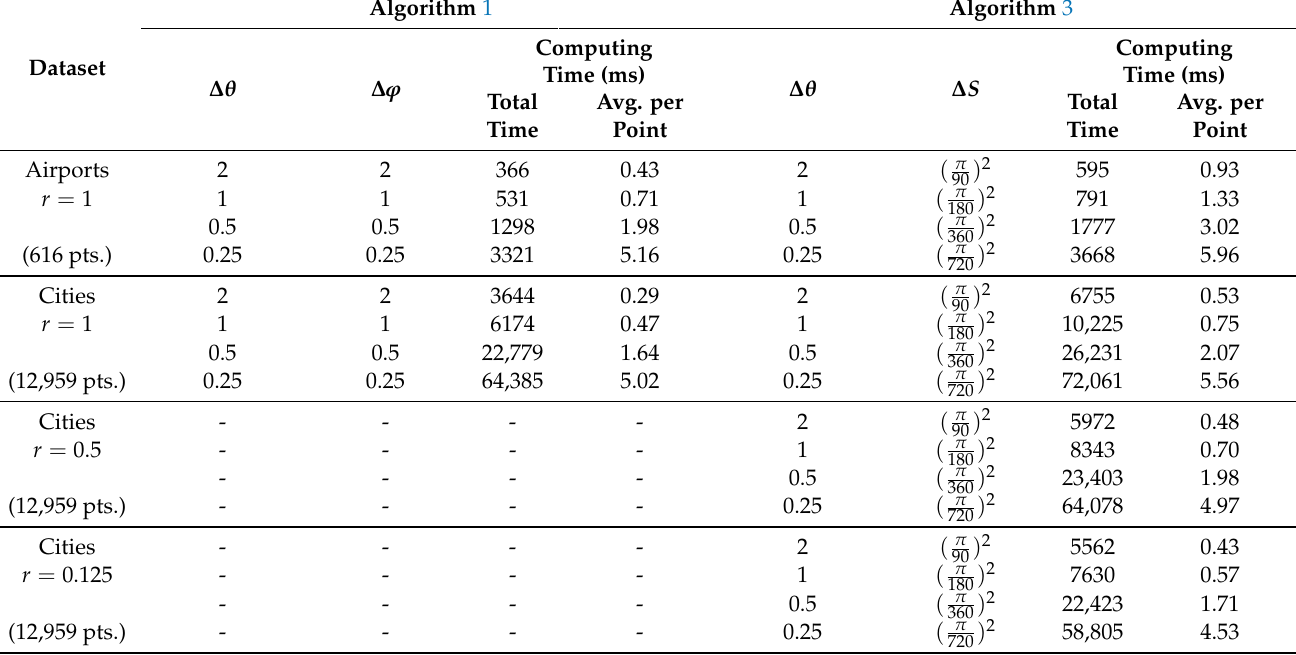
Table 1. Total computing time and computing time per-point (msec) using Matlab on a low-end PC. Results are reported for great-circle detection ( r = 1) and small-circle detection ( r < 1) and for different parameter-space resolution values ( ∆ θ and ∆ ϕ for Algorithm 1, ∆ θ and ∆ S for Algorithm